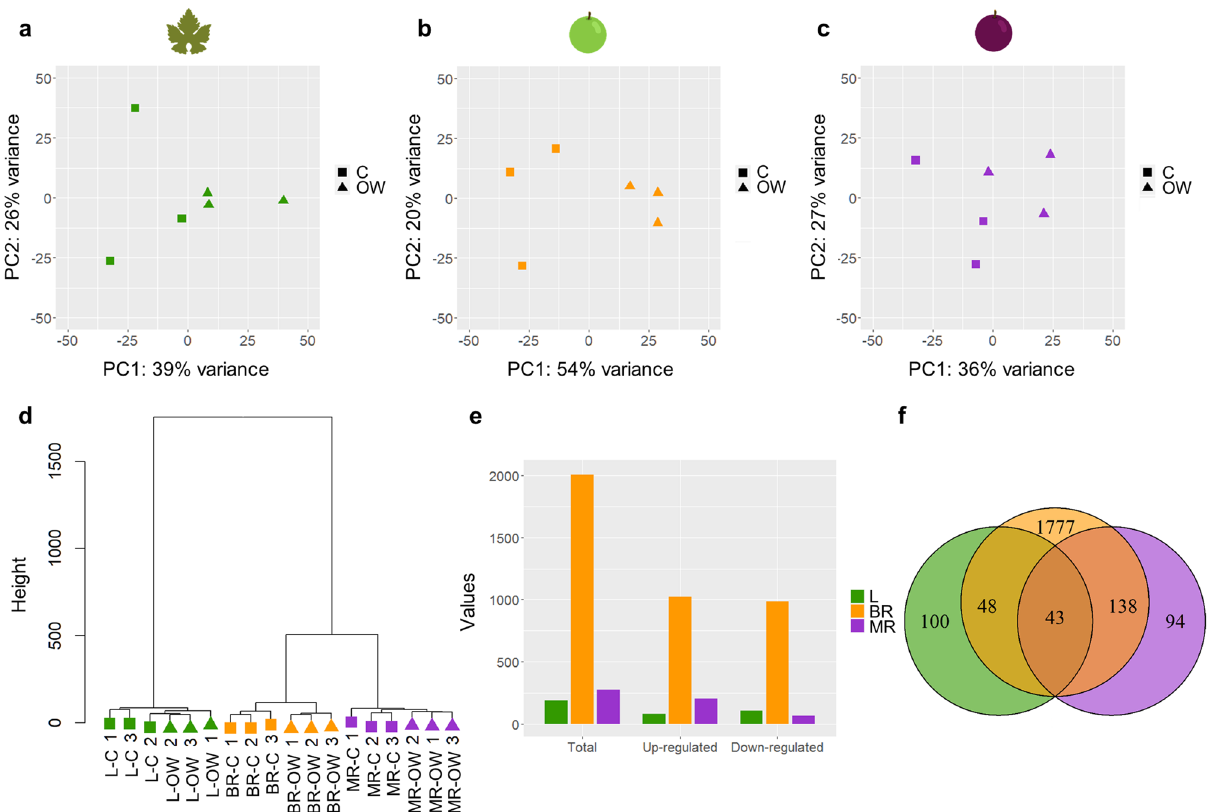
Figure 2. Transcriptomics overview. Principal component analysis of the transcriptomic samples in ( a ) leaves (L, green), ( b ) berries at the beginning of ripening (BR, orange), and ( c ) berries in mid-ripening (MR, purple); ( d ) sample dendrogram, with C and OW samples represented with a square and a triangle, respectively; ( e ) number of DEGs in L, BR and MR, and ( f ) commonly and uniquely modulated